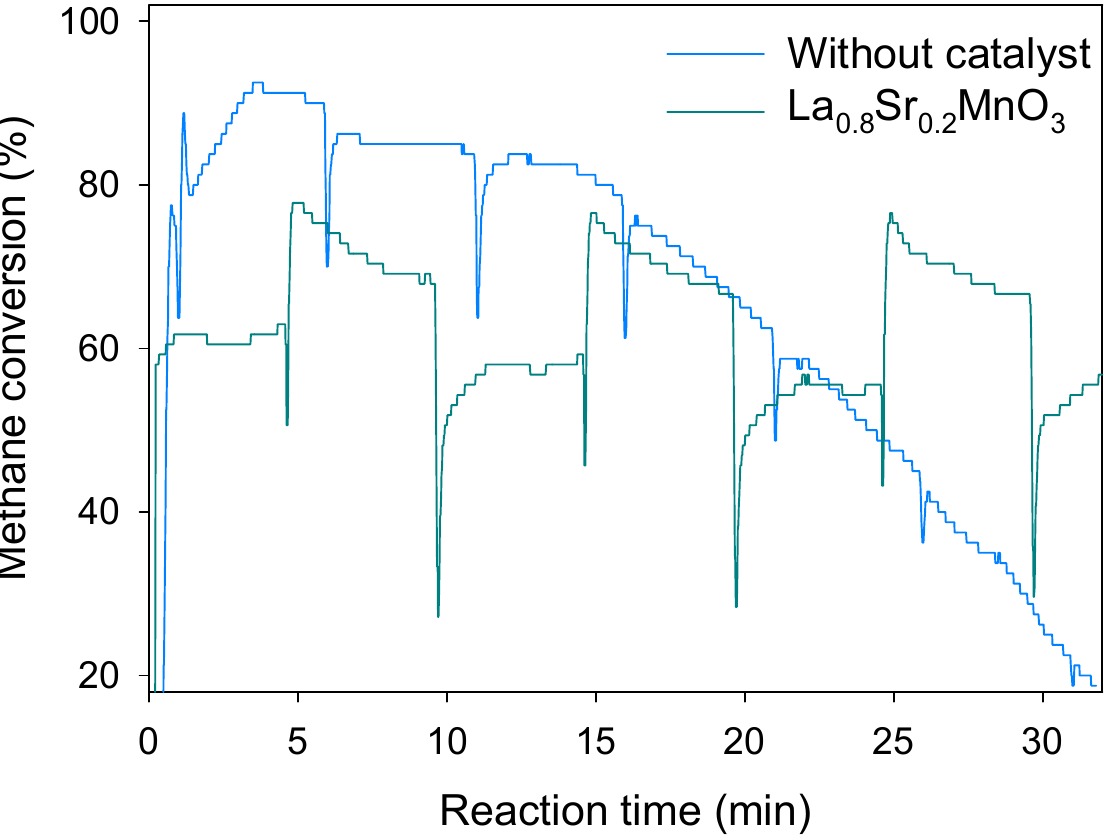
Figure 2. The conversion of methane without catalyst or with La 0.8 Sr 0.2 MnO 3 catalyst. Start-up conditions: methane inlet concentration: 0.8%, reaction temperature: 800 °C, inlet flow velocity: 1.2 m 3 /h, switch time: 5 min.